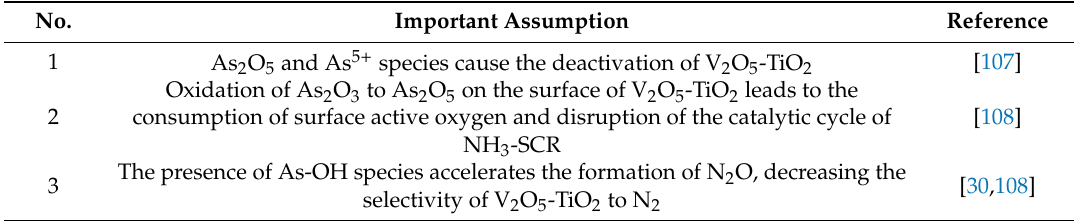
Table 6. The most important findings on the interaction of arsenic with V 2 O 5 -TiO 2